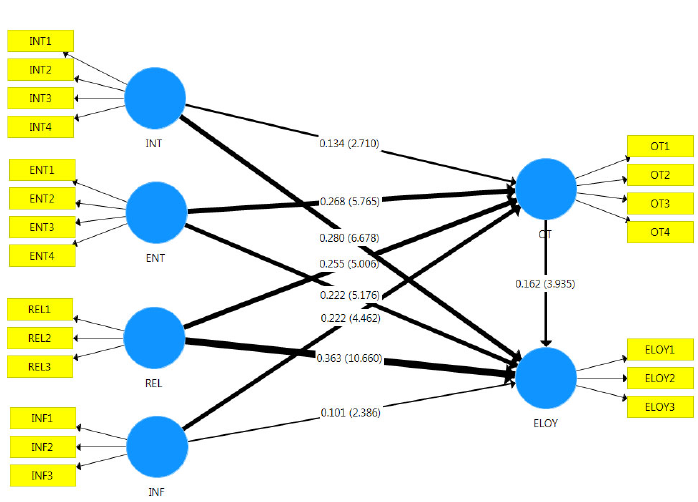
Fig. 2. Research result modelist